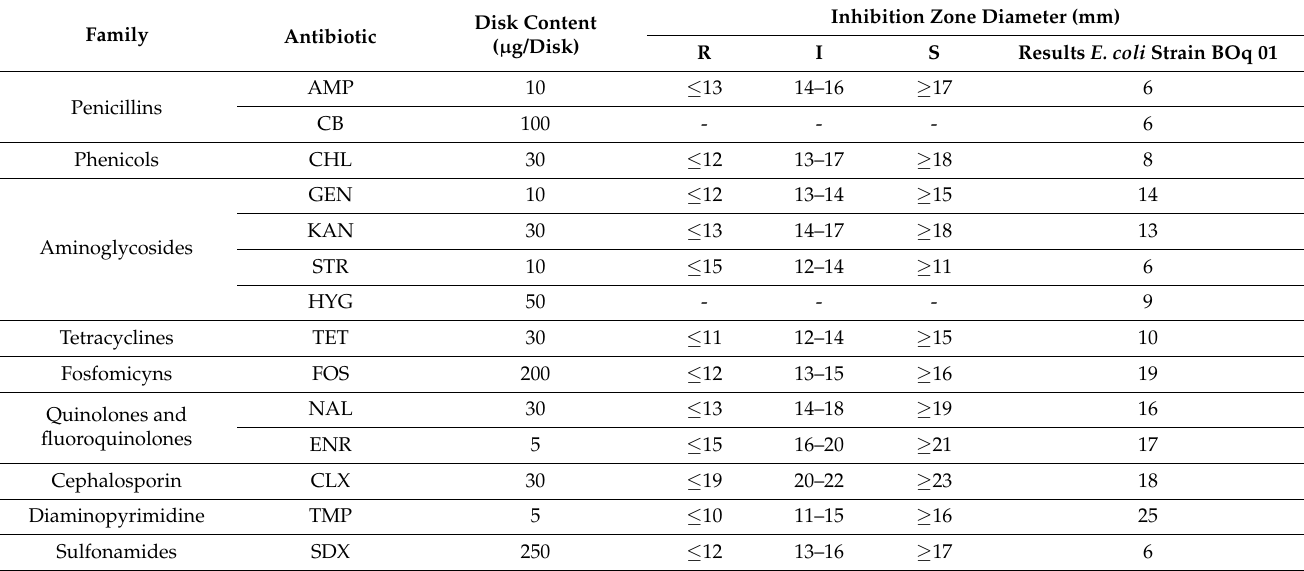
Table 1. Antibiogram test of the strain E. coli BOq 01 using 14 antibiotics grouped into 9 families.